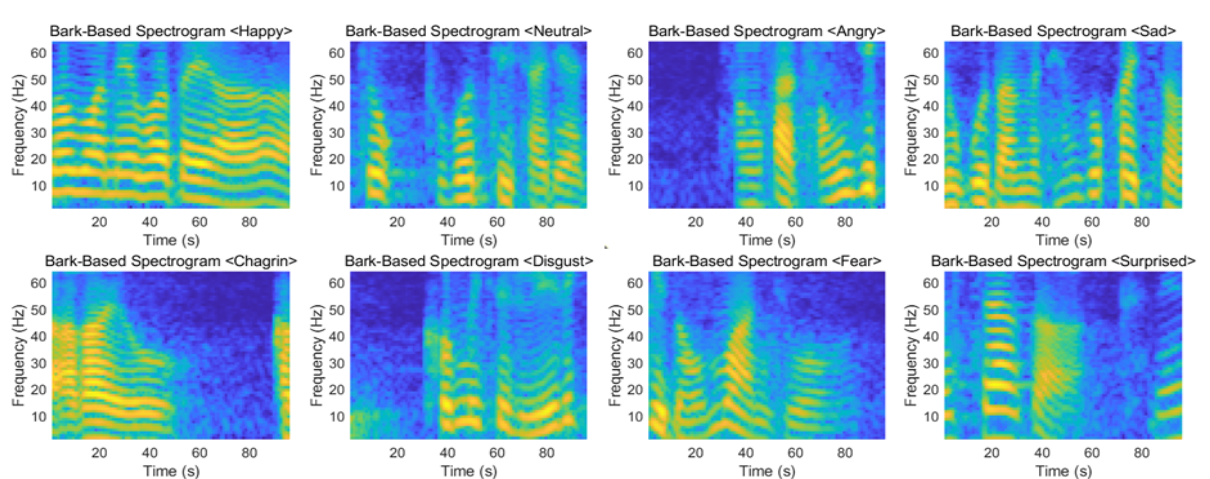
Figure 1. Visualization of Bark spectrograms for eight emotions.